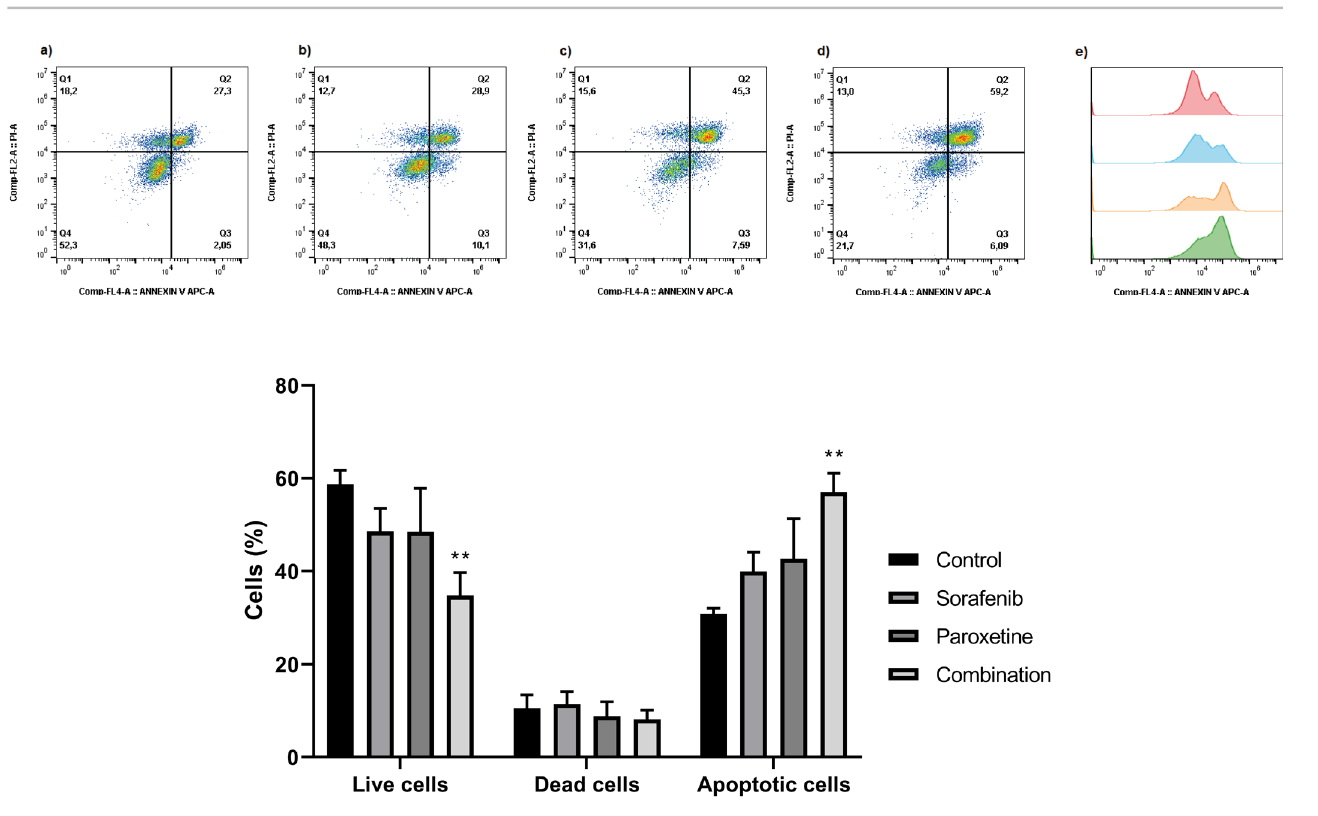
FIGURE 2 - Dot plots demonstrating apoptosis in the cells without any treatment (A), sorafenib-treated (B), paroxetine-treated (C) and co-treated with both drugs (D). Histogram overlay comparing the Annexin V staining in the four groups (E). The bar graph represents the percentages of live cells (Annexin V−/PI−), non-apoptotic dead cells (Annexin V−/PI+), and apoptotic cells that include the cells in apoptosis or those that died by apoptosis (Annexin V+/PI− and Annexin V+/PI+). Two-way ANOVA showed a significant difference among the groups (F[6,36] = 4.575). **Significant difference between the combination and control groups at P <